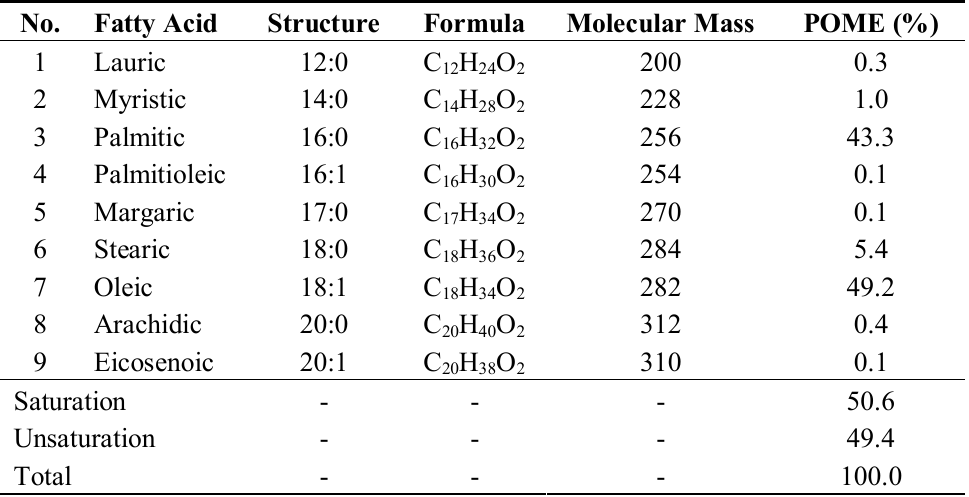
Table 3. Fatty acid composition of palm oil biodiesel by GC.